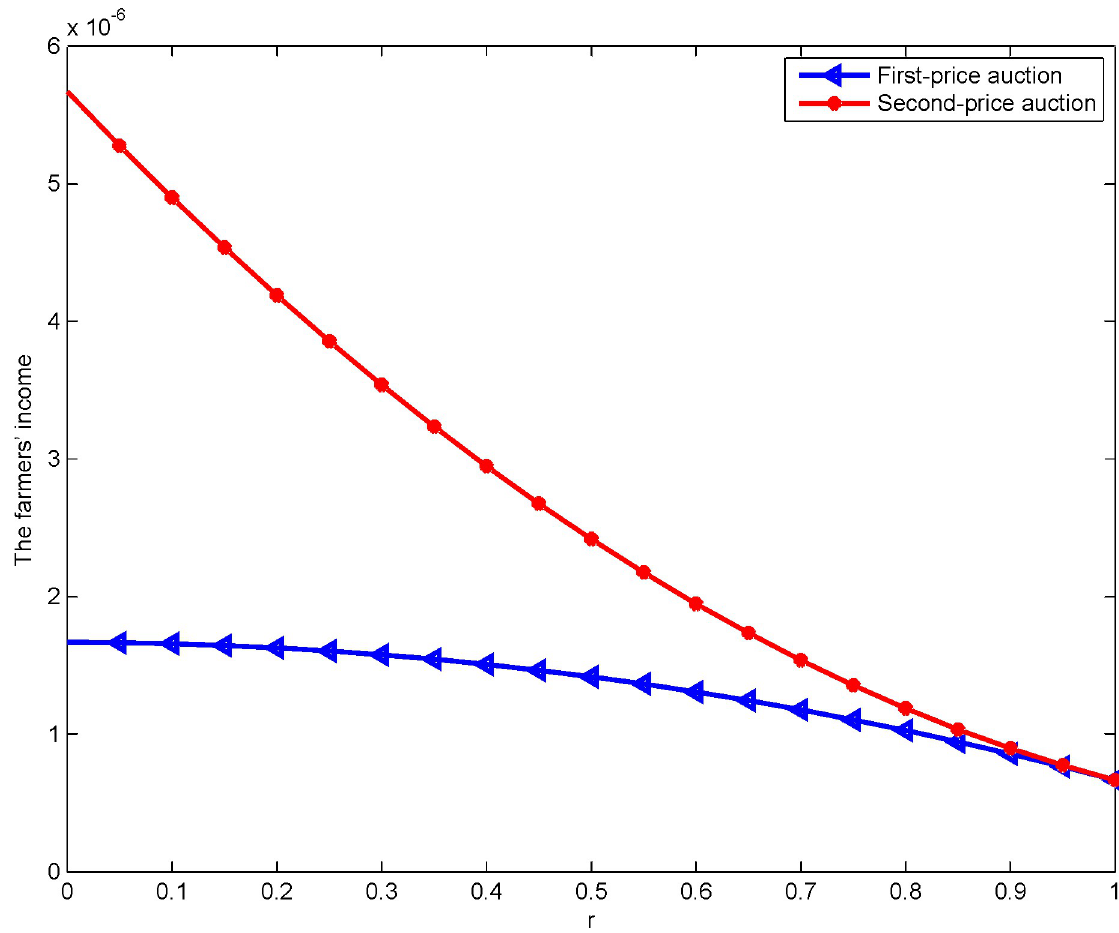
Fig 6. Impact of r